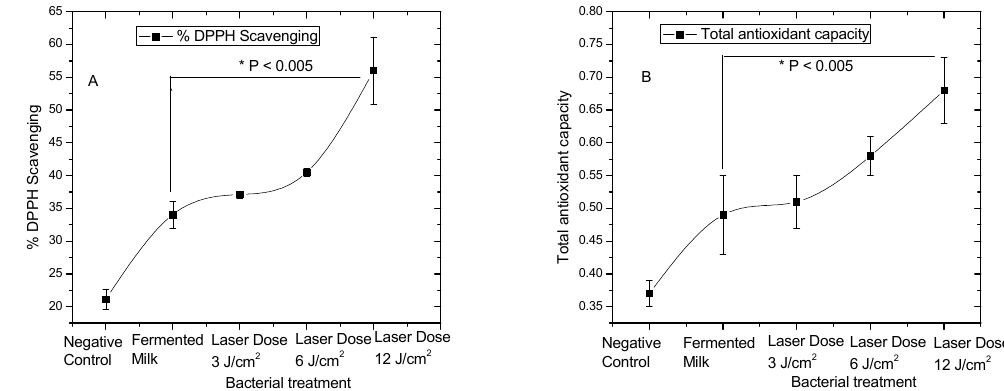
Figure 2. Effect of red laser irradiation on L. casei before skim milk fermentation as analyzed by ( A ): DPPH scavenging activity. The bars on the graph represent mean ± SD as percentage of radical scavenging activity of three independent experiments ( n = 3). and ( B ): Total antioxidant capacity. The bars on the graph represent mean ± SD equivalent to mg ascorbic acid /mL fermented milk of three independent experiments ( n = 3). * The difference was considered statistically significant ( p < 0.05).